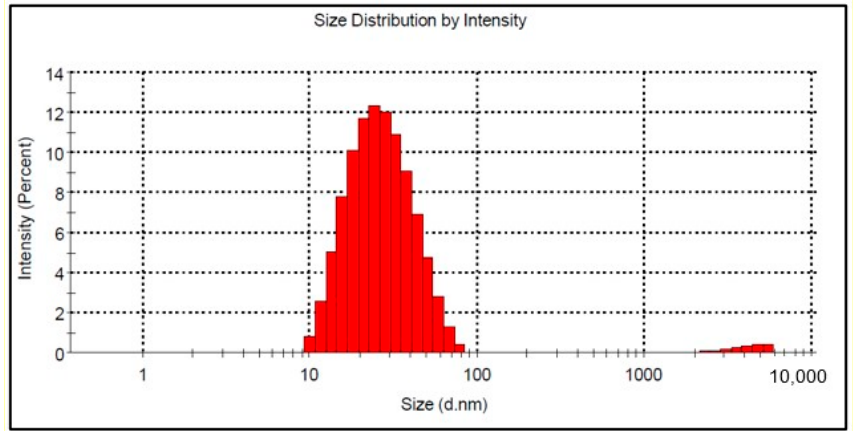
Figure 6. Mean size of BSTCo5 particles in suspension.